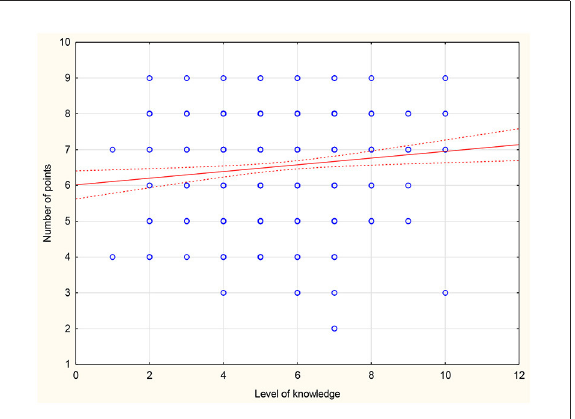
FIGURE1 Correlation between age and scores on the CKD knowledge assessment test.